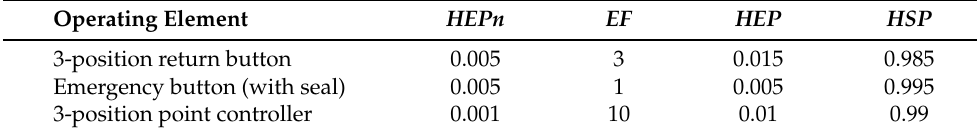
Table 11. Summary of HEP s, HSP s of operated elements (workplace B).